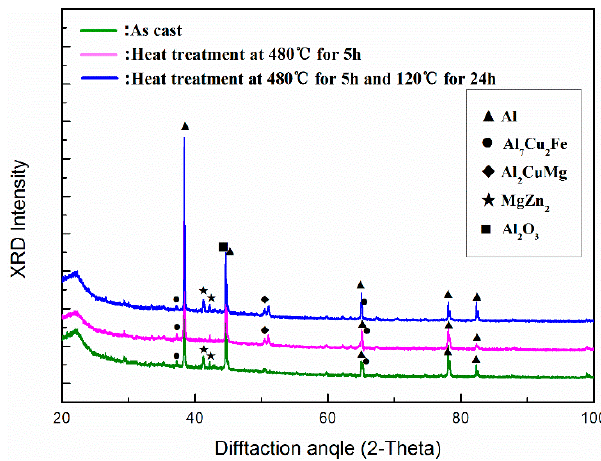
Figure 3. XRD patterns of the Al 2 O 3np /7075 composites under different heat treatment condition.